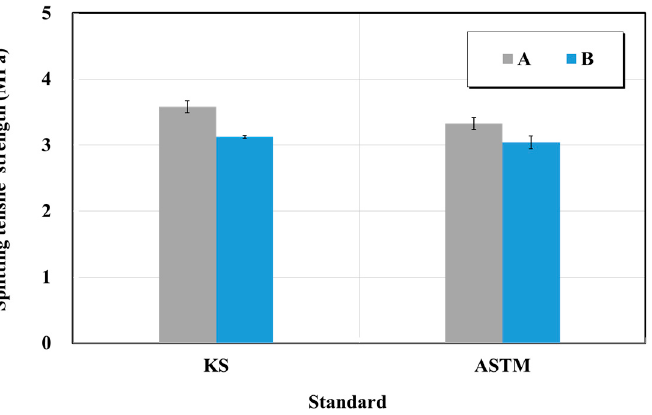
Figure 11. Splitting tensile strength test results of structure restoration material (repair mortar) obtained based on the KS and ASTM standards.